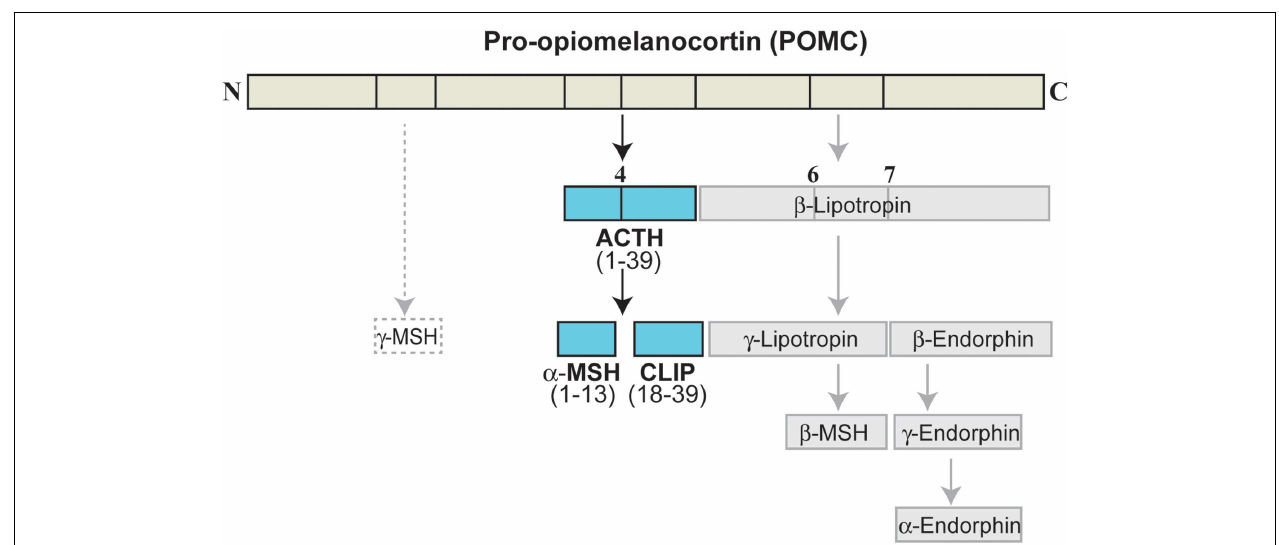
FIGURE 3 | Melanocortin peptides. ACTH, adrenocorticotropic hormone; CLIP, corticotropin-like intermediate lobe peptide; MSH, melanocyte-stimulating hormone.